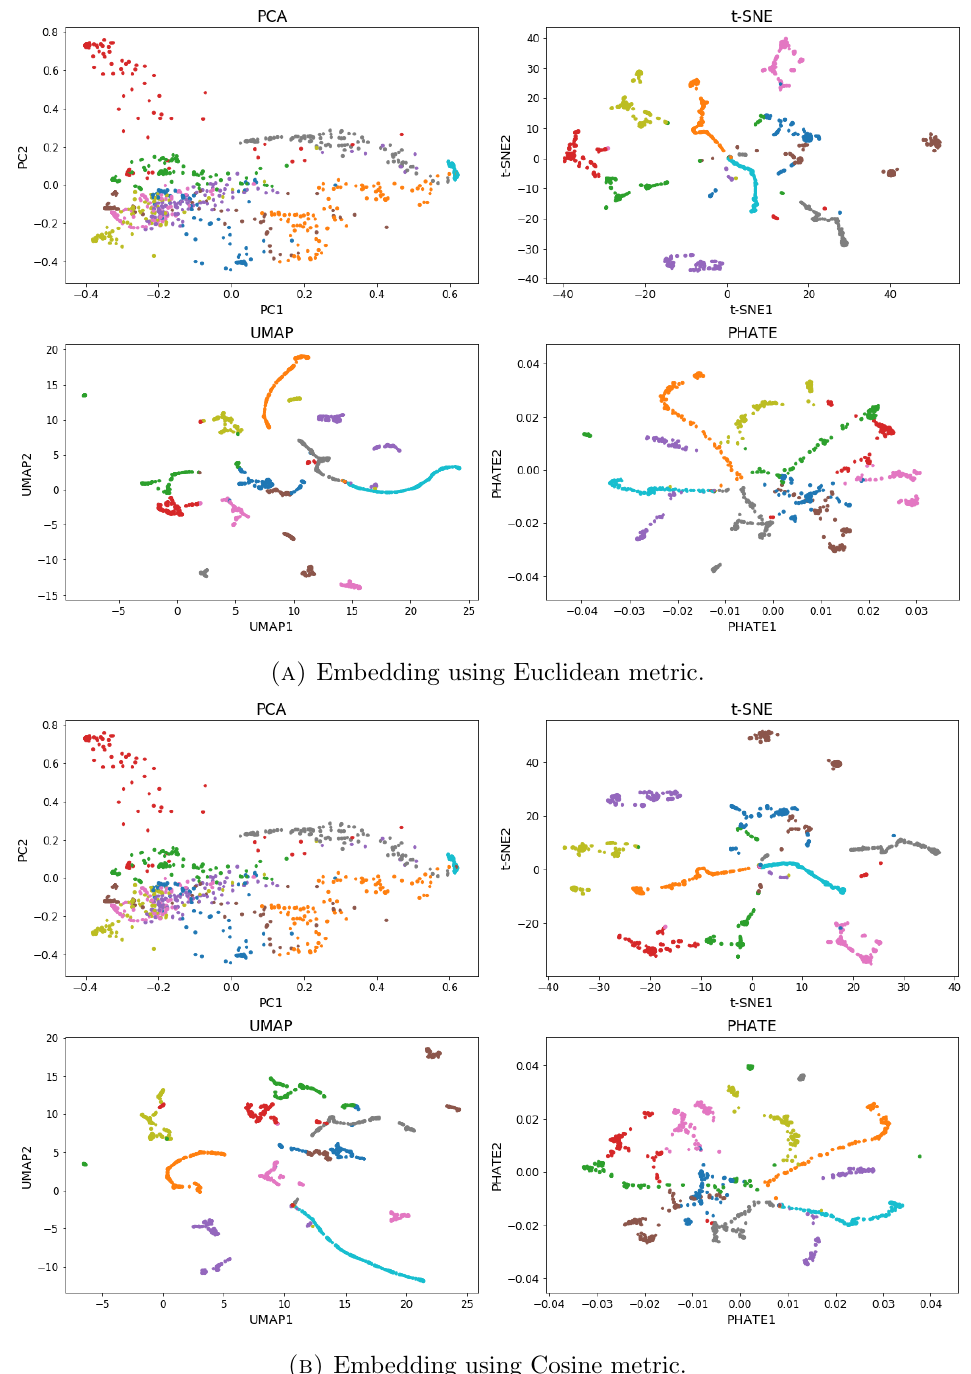
Figure E.4. Principle component analysis (PCA), t-distributed stochastic neighbor embedding (t-SNE), uniform manifold approximation and projection (UMAP), and potential of heat-diffusion for affinity-based transition embedding (PHATE) using Euclidean and cosine metrics. Here 10 trajectories of 100 -dimensional probability vectors are generated, where the trajectories are colored differently. PHATE gives the clearest 2D representation of the inputs that preserves their high-dimensional progressive structures, regardless of the distance metric used. Comparing with Figure 3, the Hellinger metric outperforms the other two metrics in recovering the data